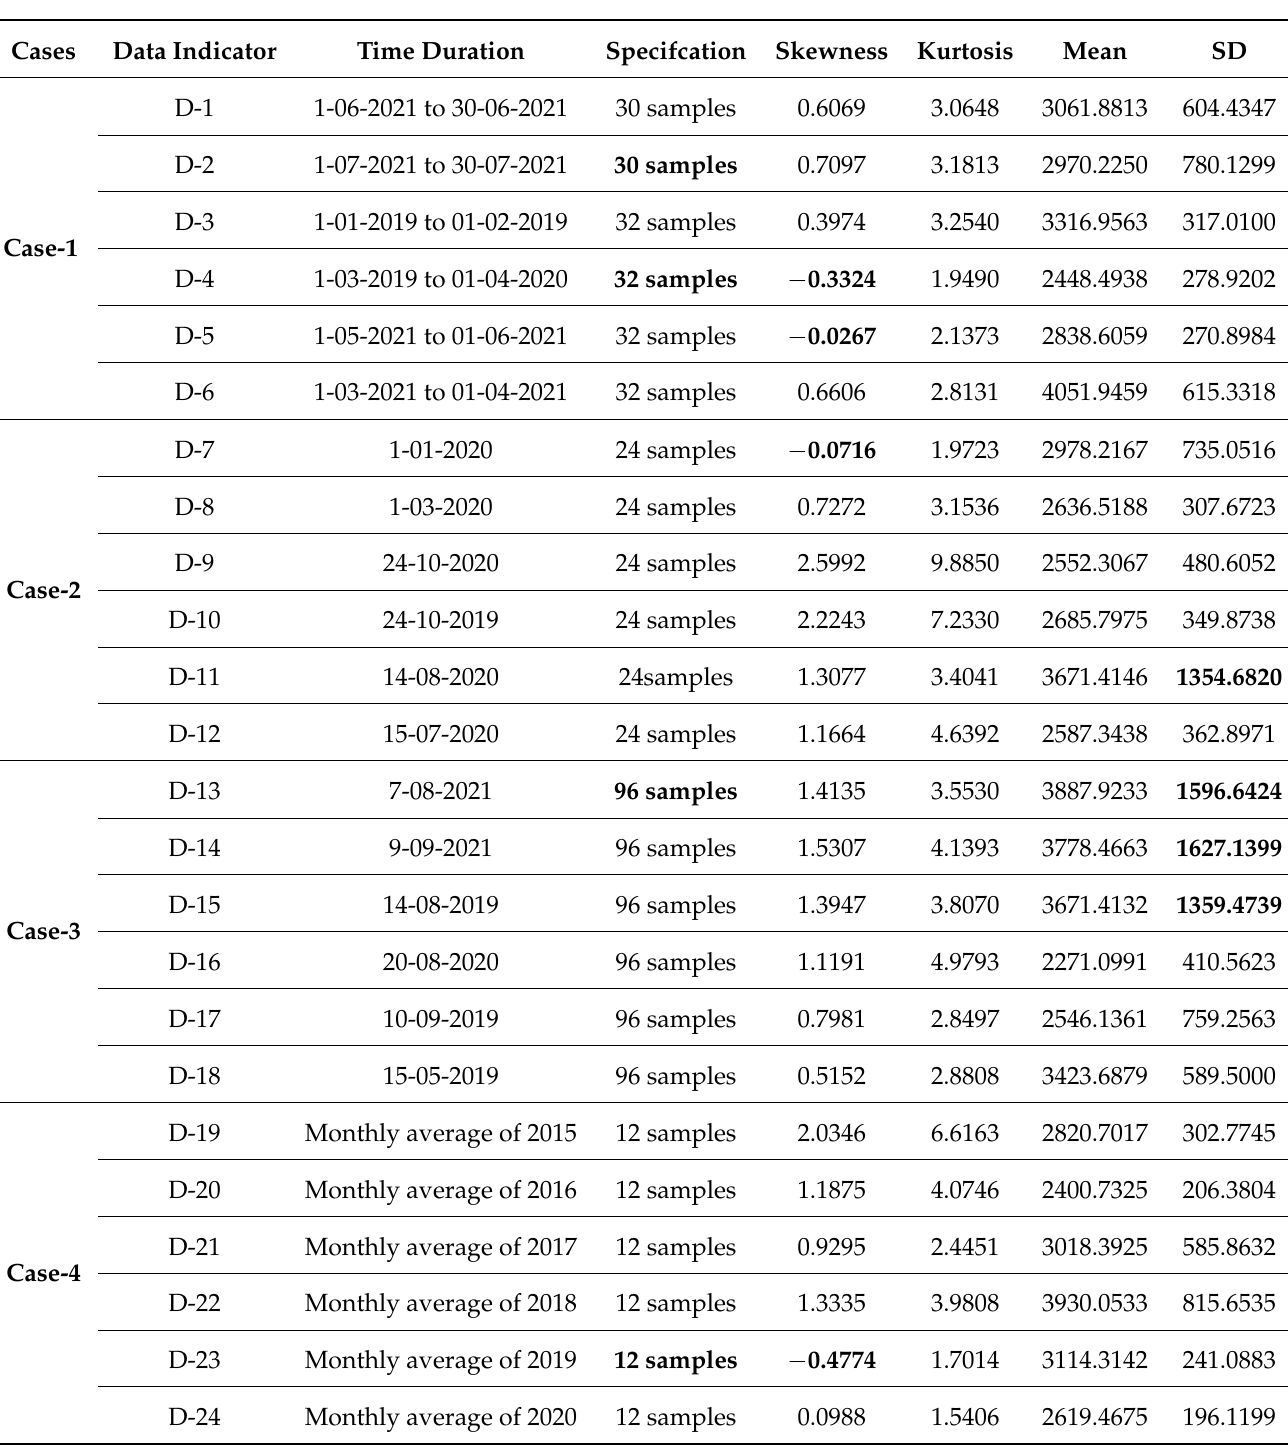
Table 1. Data sample details and statistical